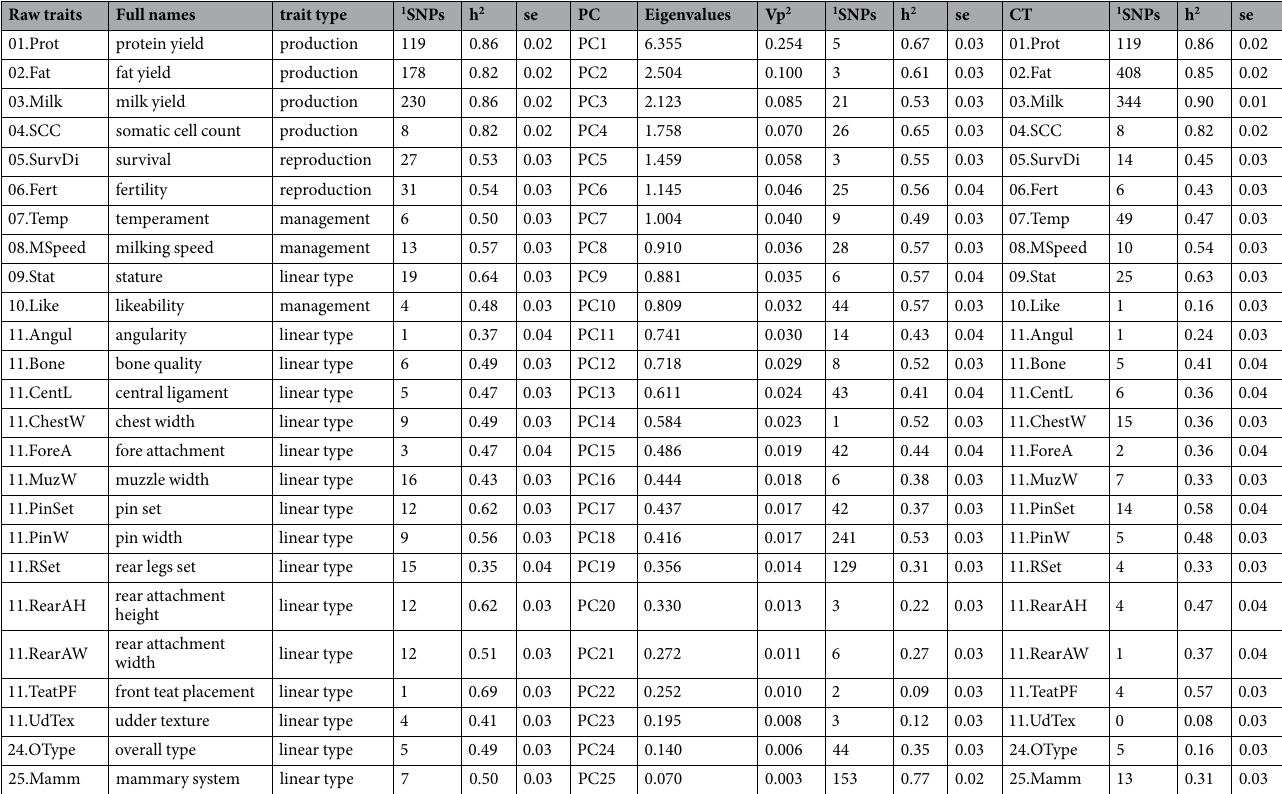
Table 1. Summary of single-trait genome-wide studies (GWAS) results for raw traits, principal components (PCs) and Choleskey transformed traits (CTs). 1 The number of SNPs with single-trait GWAS P < 1 × 10 − 5 . 2 Total phenotypic variances explained by each principal